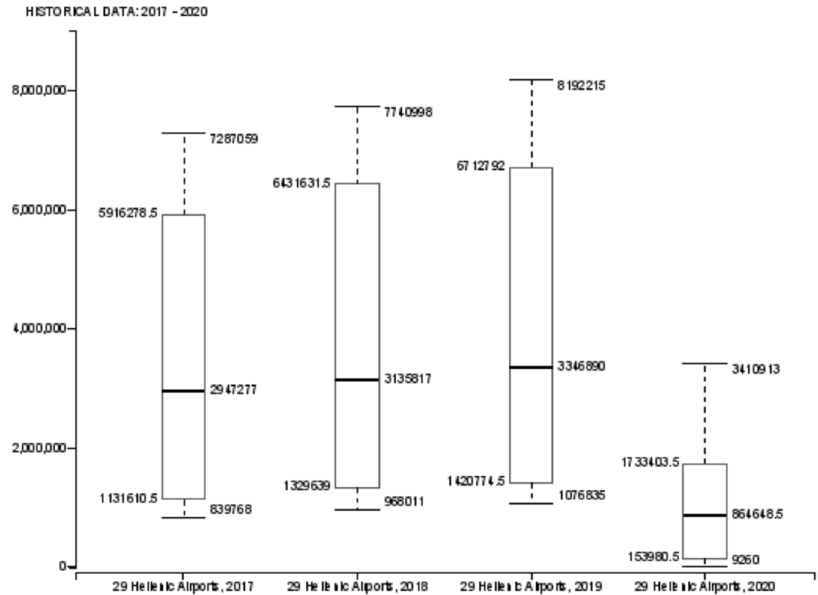
Figure 2. Box plots for annual international pax air traffic in Greece from 2017 to 2020. (The box plots for the 29 Hellenic International airports were drawn with the KNIME Analytics Platform. All measures (median, quartiles) were calculated directly from the data sets.)